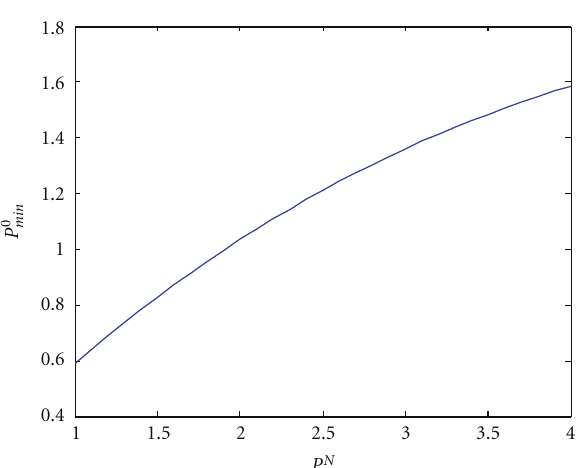
Figure 8: The minimum required P 0